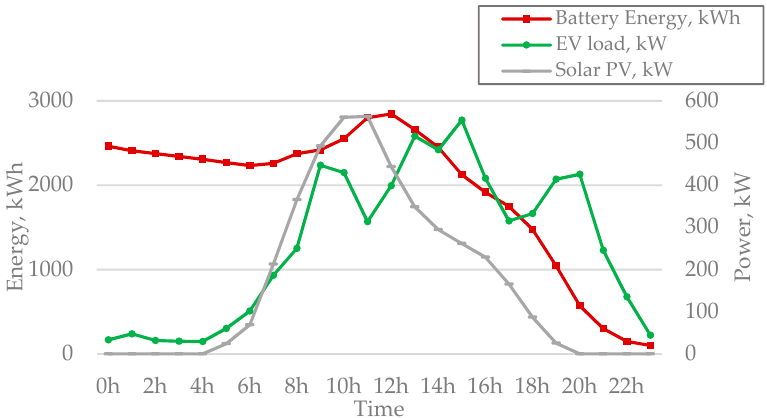
Figure 7. Battery energy, E > 0 with larger sized battery.